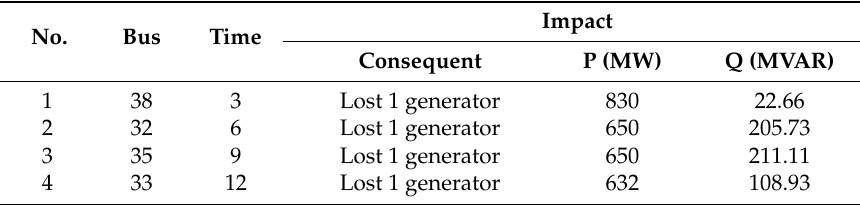
Table 5. Attack sequence and the information of targets.